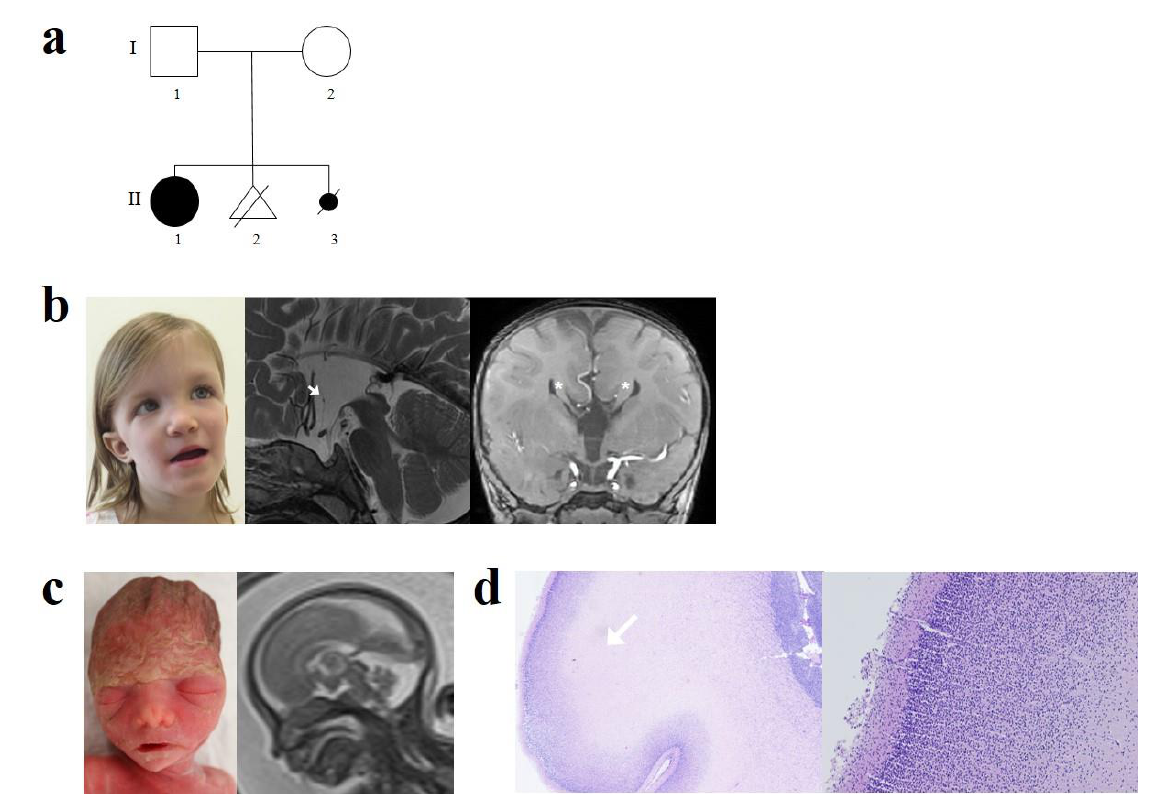
Figure 1. ( a ) Pedigree of the family. ( b ) II1: Photograph of the index case: note the large forehead, prominent metopic region, down slanting palpebral fissures, epicanthal fold, bulbous nasal tip and high nasal bridge, thin upper lip, low set ears. Brain MRI: Complete agenesis of the corpus callosum. Hypoplastic anterior commissure (white arrows), absence of interthalamic adhesion on T2-weighted sagittal sequence. Presence of Probst bundles (*) on T1-weighted coronal sequence. ( c ) II3: 24 GW fetus, mild hypertelorism. Fetal brain MRI at 22 GW: Truncated corpus callosum with absent splenium. ( d ) Histopathological examination of the fetal brain showing normal cortical laminar organization-hematoxylin-eosin, original magnification ×4 and ×10.